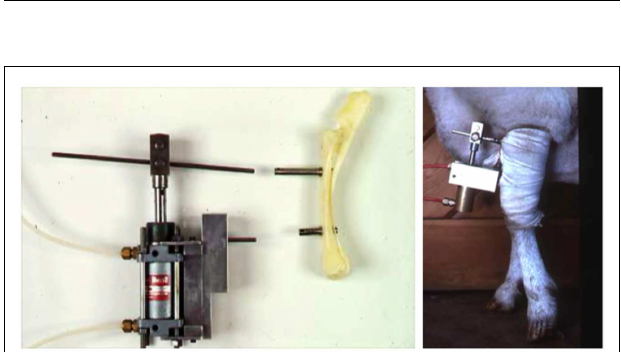
FIGURE 3 |The invasive sheep loading model . Lance Lanyon adapted Hert’s original loading model to the sheep radius and combined the loading with strain measurements using implanted strain gages